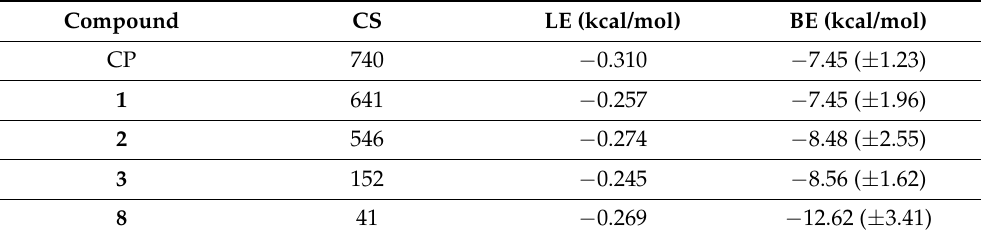
Table 6. DNA gyrase binding data based on docking results for CP and its derivatives. Data obtained for docking of ligands to crystal structure PDB ID: 5BTC (DNA gyrase in complex with DNA and CP) [34].